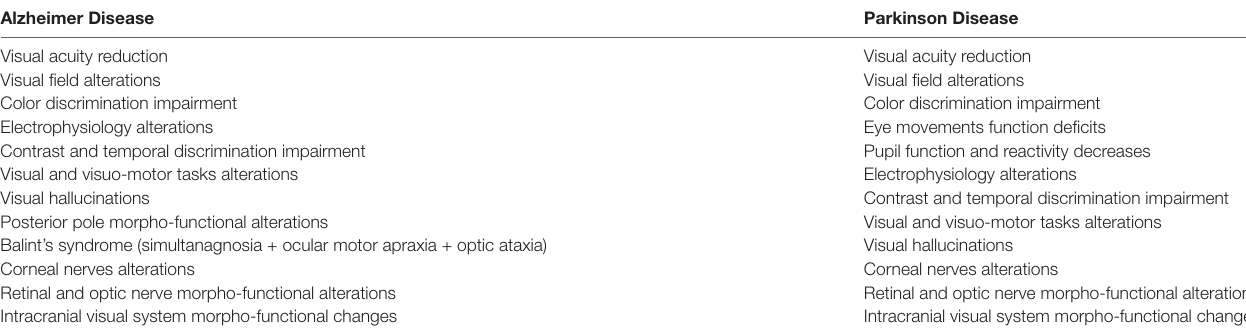
TABLE 1 | Main visual system alterations in neurodegenerative